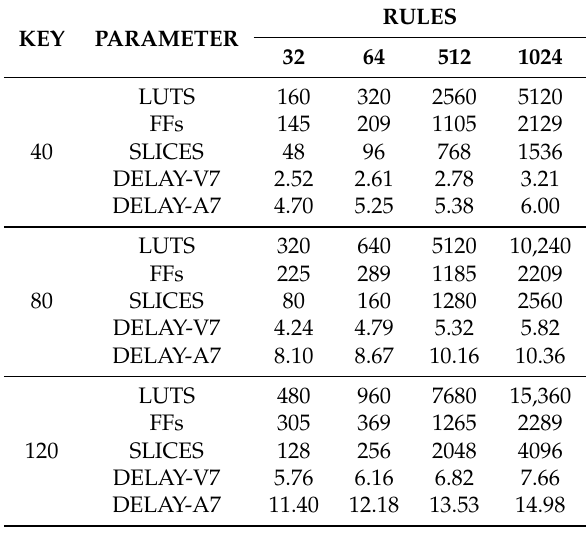
Table 1. Resource and Delay (in nanoseconds) Results for BPR-TCAM on Artix-7 XC7A100T